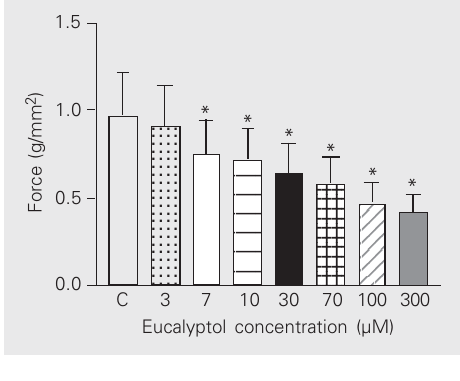
Figure 2. Effect of increasing concentrations of eucalyptol on the parameters time to peak tension (TPT, upper panel) and relaxation time (lower panel) of the isometric force developed by rat papillary muscles. Data are reported as means ± SEM for N = 8. *P < 0.05 for eucalyp- tol vs control (C, one-way ANOVA).